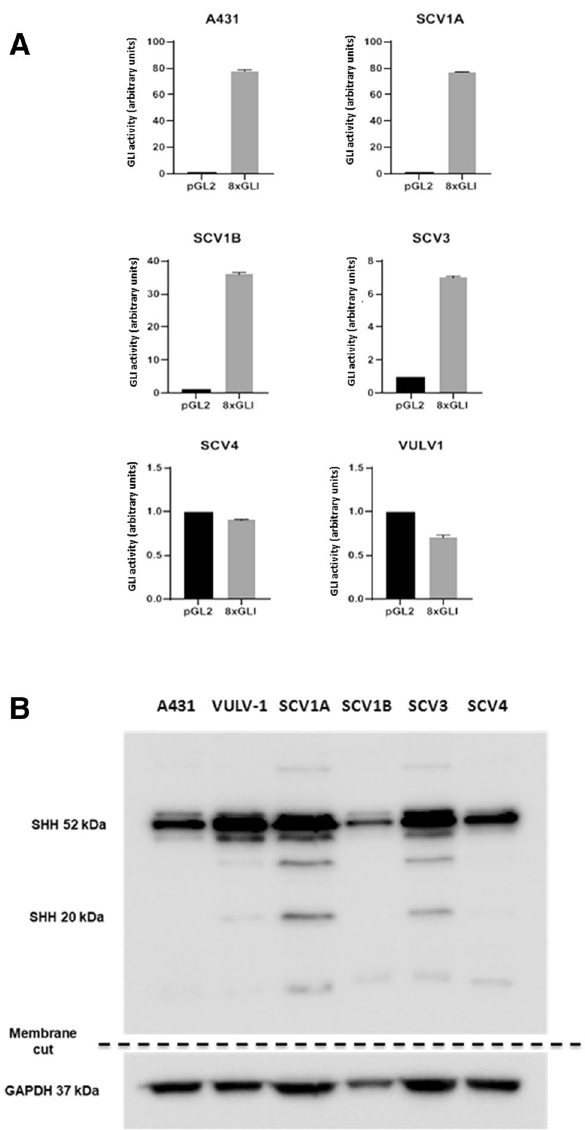
Figure 2. Baseline Hh pathway activity is elevated in 4 of 6 VSCC-derived cell lines. ( A ) Transient transfection of cells with a GLI-reporter (pGLIx8) revealed elevated baseline Hh-GLI activity in A431, UM ‐ SCV ‐ 1A, UM ‐ SCV ‐ 1B and UM ‐ SCV ‐ 3 but not in UM ‐ SCV ‐ 4 and UCI-VULV1. ( B ) Representative western blotting analysis demonstrating expression of mature, “processed” SHH protein in UM-SCV1A, UM-SCV1B and UM-SCV3; low levels were observed in UM-SCV4, A431 and UCI-VULV1 cells. All experiments were performed three